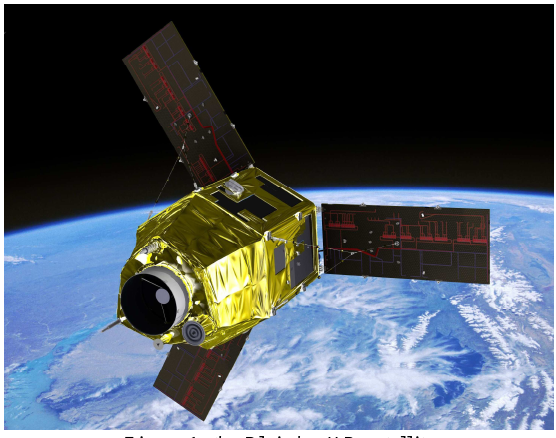
Figure 1: the Pleiades-HR